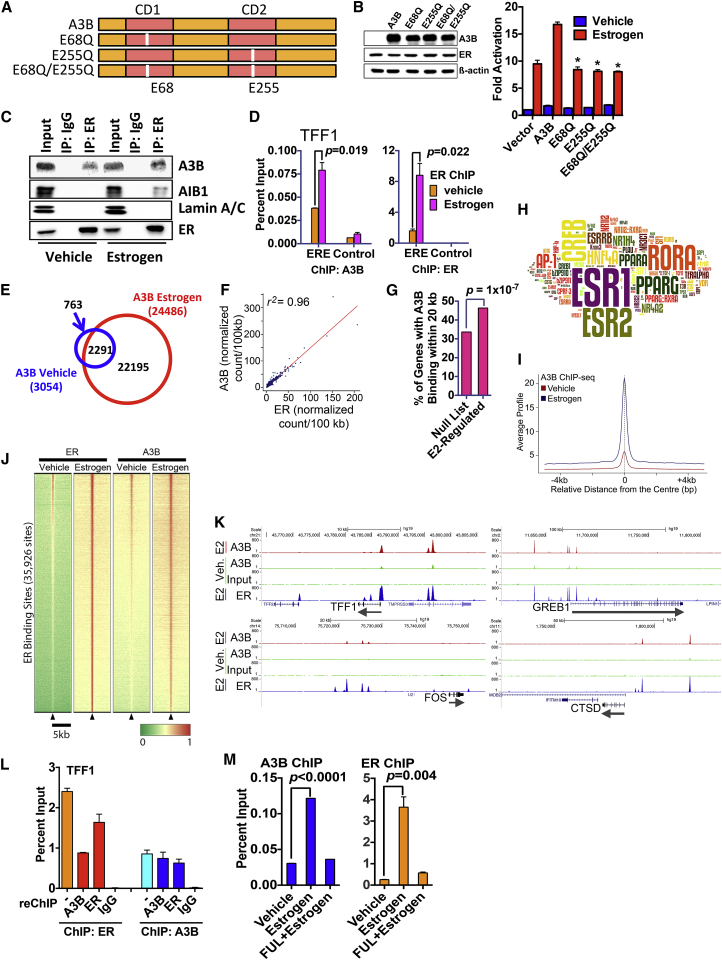
A3B Interacts with ER and Is Recruited to ER Binding Regions(A) Schematic representation of A3B. Highlighted are the catalytic site mutations used here.(B) COS-1 cells cultured in hormone-free medium were transfected with an estrogen-responsive luciferase reporter gene, ER and A3B. Estrogen (10 nM) was added for 20 hr. Data are shown as fold activation, relative to reporter activity for vehicle treatment, following co-transfection of ER without A3B (vector control) (n = 3; ∗ = p < 0.05). Immunoblotting for ER and A3B following transfection of COS-1 cells is also shown.(C) Hormone-depleted MCF7 cells treated with estrogen were immunoprecipitated with an ER antibody. Input represents 10% of lysate used in the immunoprecipitations.(D) MCF7 cells were treated with estrogen (10 nM, 45 min), followed by ChIP. Shown are the results of real-time PCR of ChIP DNA for the TFF1 gene promoter proximal ERE or a control region in the TFF1 gene to which ER binding is not observed (n = 3).(E) A3B ChIP-seq was carried out following treatment of MCF7 cells with 10 nM estrogen for 45 min. The Venn diagram shows A3B binding regions from the peak-calling analysis.(F) Genome-wide enrichment correlation analysis for A3B and ER raw signals demonstrates correlation (r2 = 0.96) between A3B and ER binding sites. A3B and ER ChIP-seq reads were normalized (wig file) and binned in windows of 100 kb where the average score was calculated. The data were then used to calculate genome-wide correlation using a Spearman’s correlation score. The score for each window is plotted and an interpolation line added to ease interpretation.(G) Analysis of A3B binding regions identified by ChIP-seq are significantly enriched in the proximity of estrogen responsive genes.(H) Analysis of the relative enrichment of transcription factor binding sites was used to generate a Z score, which is represented by the size of the motif in the word cloud.(I) Average signal intensity of A3B ChIP-seq binding events, centered on ER binding regions, shows increased recruitment of A3B to ER binding regions globally, upon estrogen treatment. Signal intensity is a normalized count of individual, non-redundant ChIP fragments at single ER binding sites identified by the peak-calling algorithm (MACS 1.4)(J) Heatmap showing clustered binding signal for A3B ± estrogen. The window represents ±2.5-kb regions from the center of the ER binding events. The color scale represents relative enrichment based on raw signal.(K) Representative genome browser snapshots show A3B binding regions and overlap with ER binding regions, shown on the same scale.(L) ChIP with ER or A3B antibodies (denoted by −) was followed by recovery of the chromatin complexes and reChIP with antibodies for A3B, ER, or mouse immunoglobulins (IgG control) (n = 3).(M) MCF7 cells were treated with fulvestrant for 24 hr, followed by addition of estrogen for 45 min (n = 3).